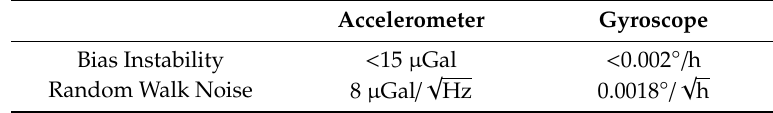
Figure 4. Reference sensor equipment layout. Table 2. Technical characteristics of iNAV-RQH.